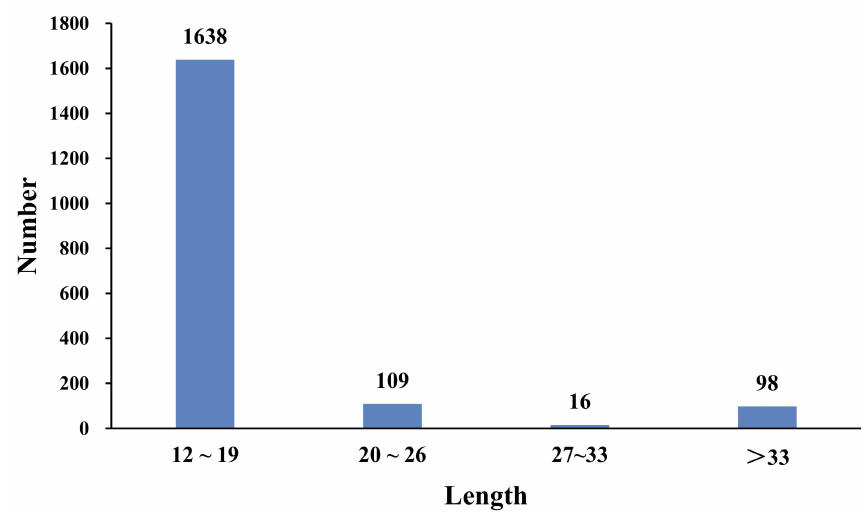
Figure 5. Length distribution of microsatellites in the B. dorsalis transcriptome.